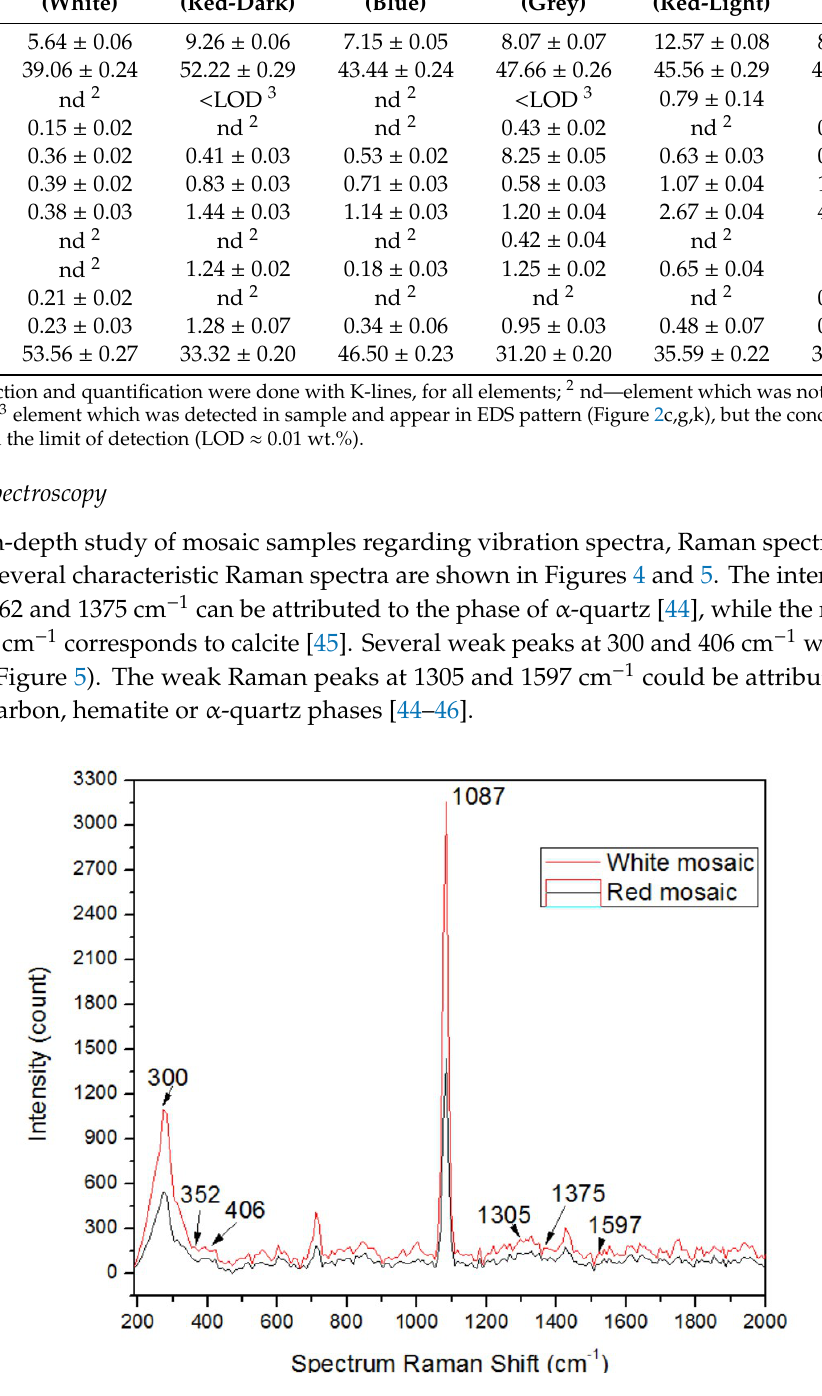
Figure 4. Raman spectra obtained from surfaces of samples 1 and 2 and corresponding to calcite and quartz phases. The tentative assignment of Raman lines is present in Table 4.